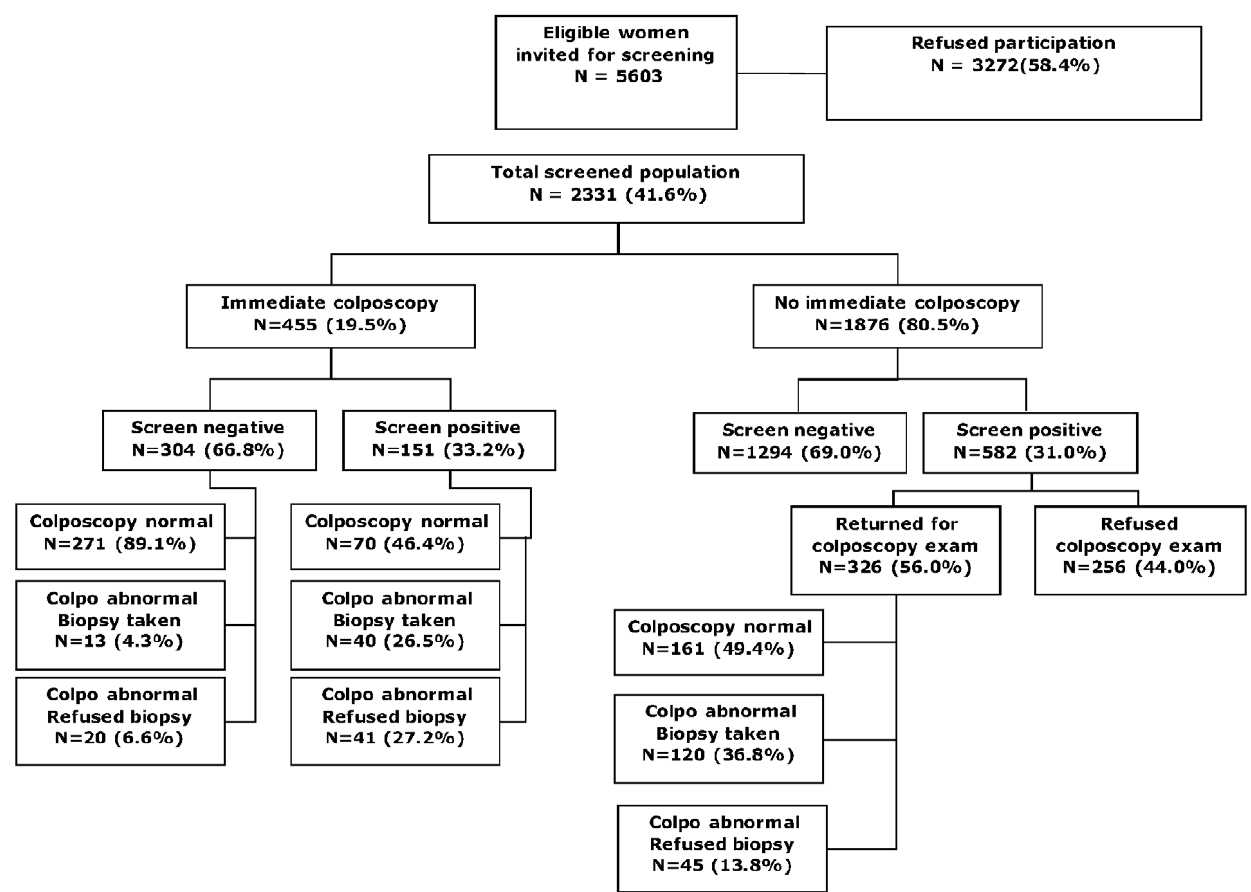
Figure 1. Participation in screening and follow-up (colposcopy and biopsy where recommended) by randomization arm and screening result. Screen positive indicates positive result on VIA, Pap, and/or HPV DNA testing. Colposcopy normal indicates no area of abnormality identified, no biopsy recommended. Colposcopy abnormal-biopsy taken indicates that a biopsy was successfully obtained from all visually identified areas of abnormality. Colposcopically abnormal-biopsy refused indicates that a lesion was visualized and biopsy recommended, but the patient refused.